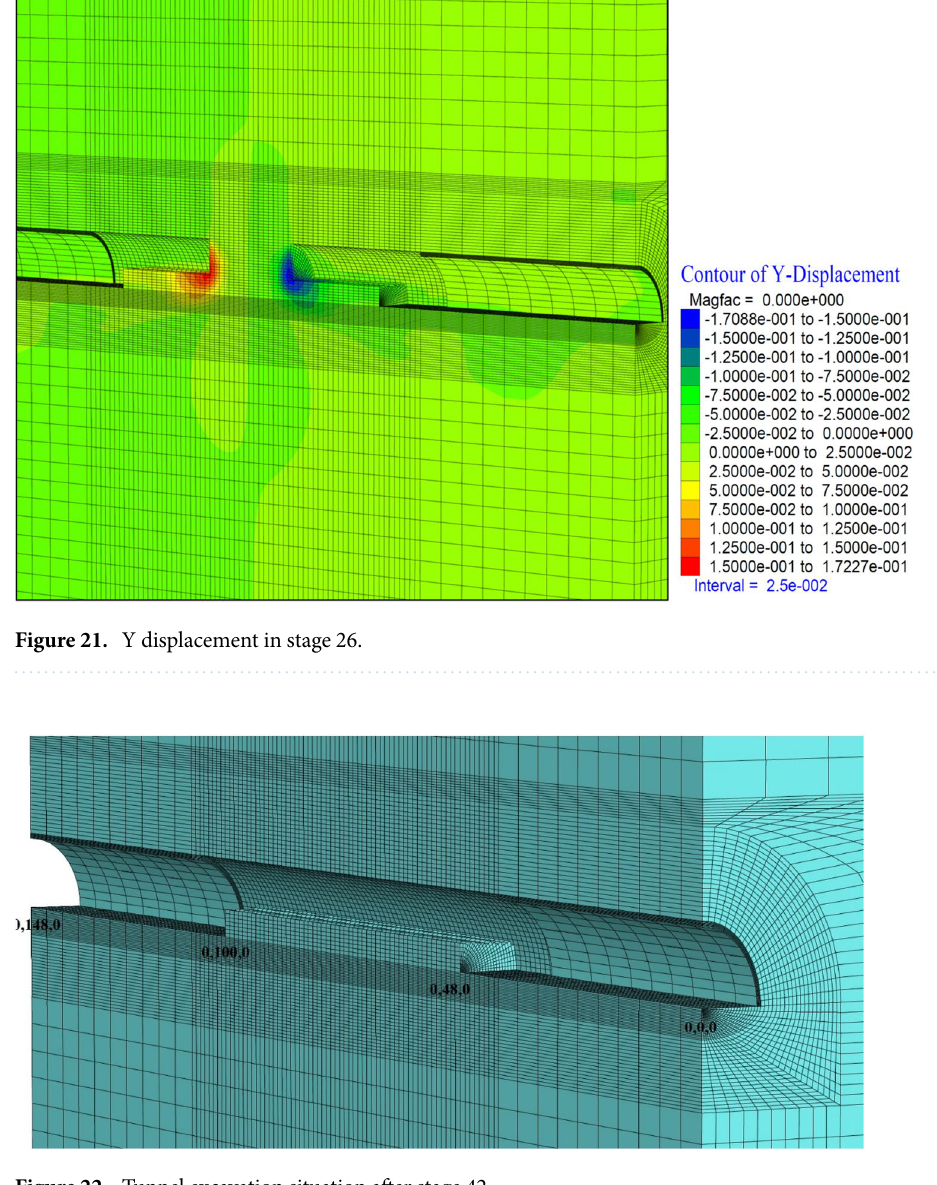
Figure 22. Tunnel excavation situation after stage